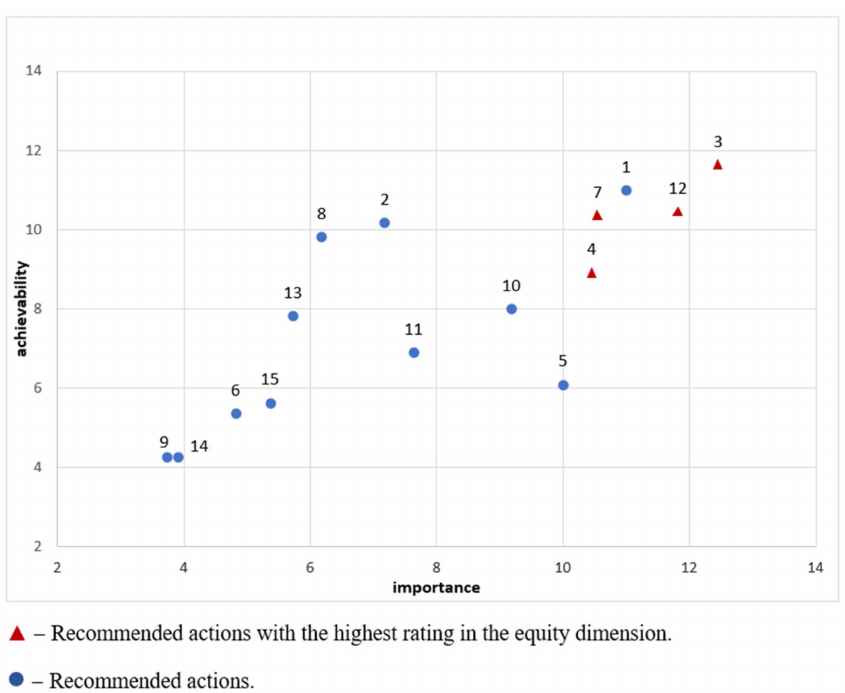
Figure 5. Recommended policy actions with details regarding importance and achievability (no weighting). The numbers in the diagram have been determined in accordance with the information on the numbers appointed to recommended actions (see Table